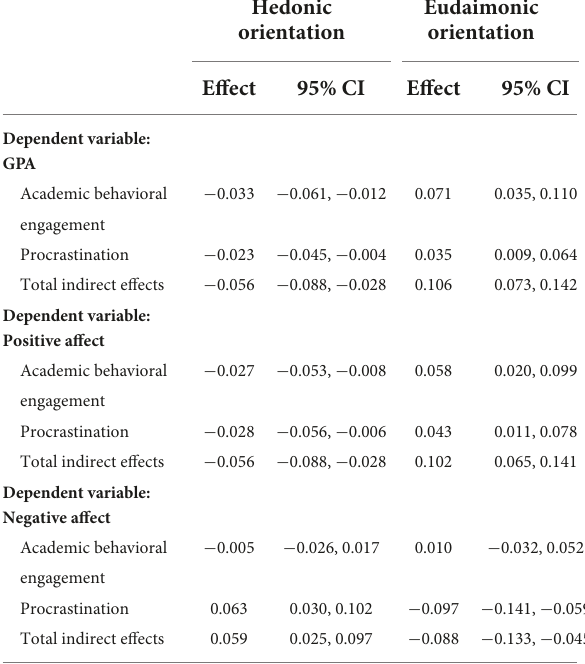
TABLE 3 Indirect effects of happiness orientation on GPA, positive affect, and negative